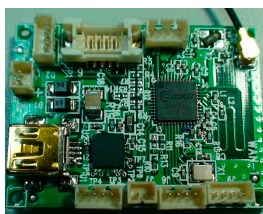
Figure 8. MICRO TECH WAN-1 wireless sensor network development platform.